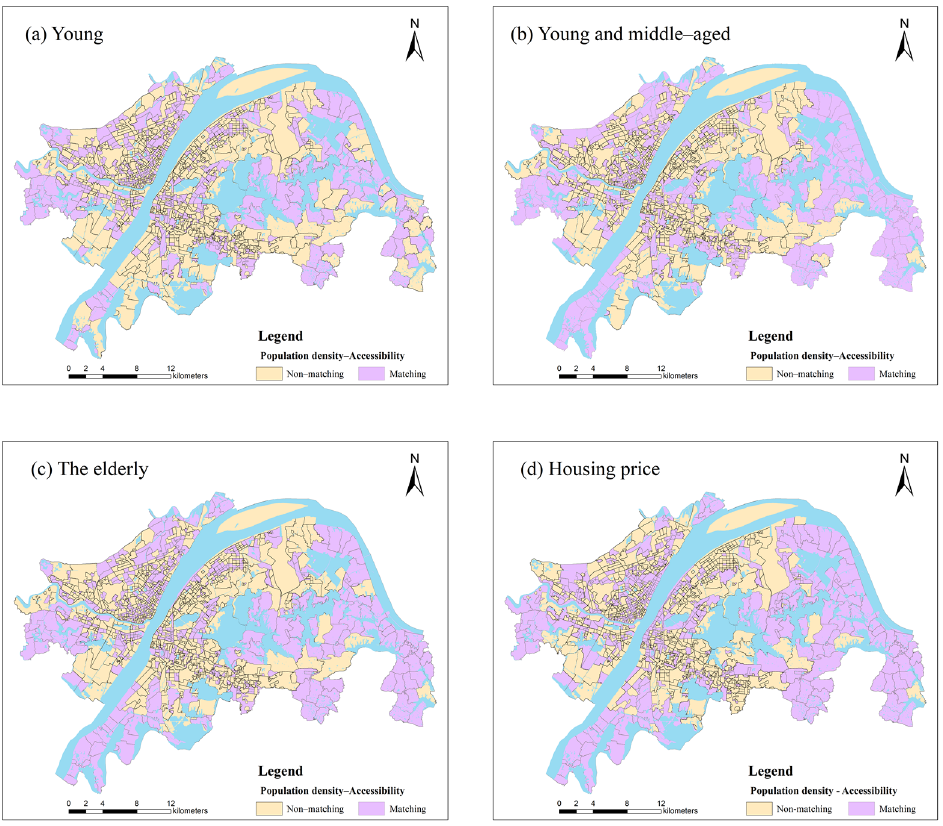
Figure 6. Spatial distribution of matching and non – matching between population density, housing price and park green space accessibility: ( a ) youth, ( b ) young and middle – aged, ( c ) the elderly and ( d ) housing price.